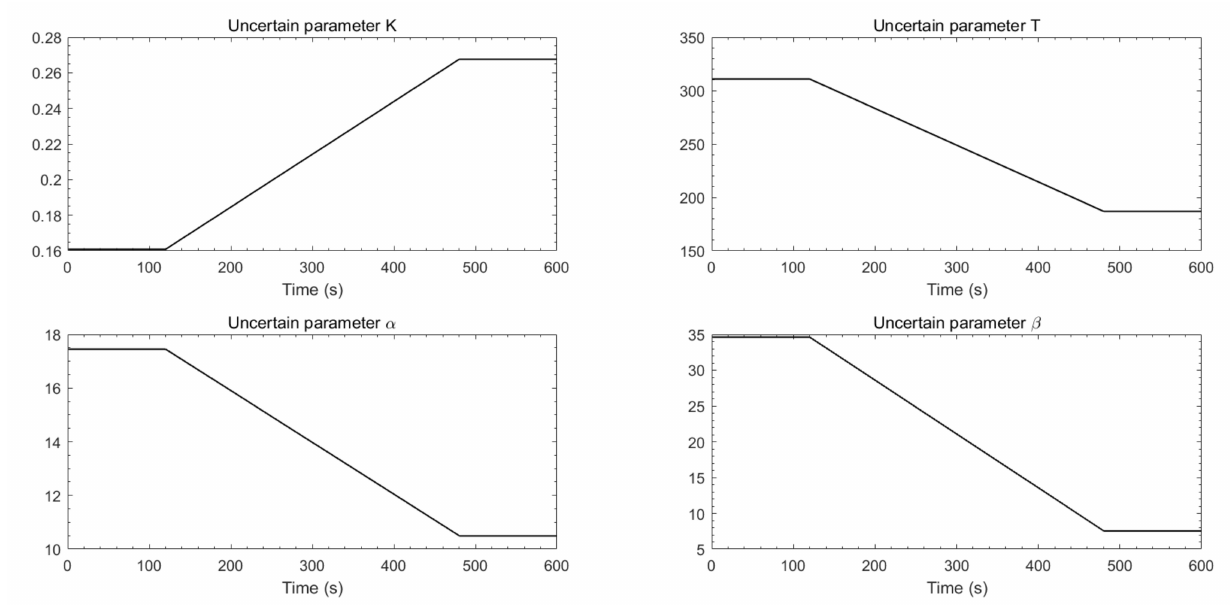
Figure 9. Changing curve of uncertain parameters T , α , β V